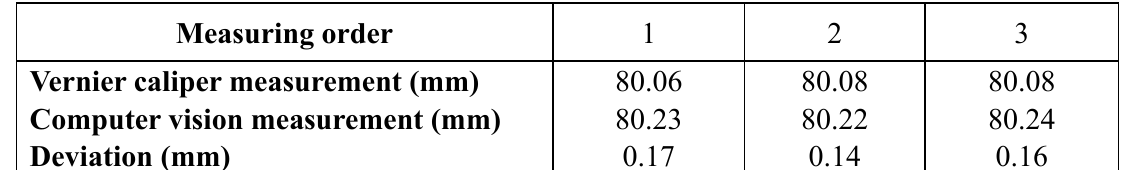
Table 2. Measurement results’ comparison